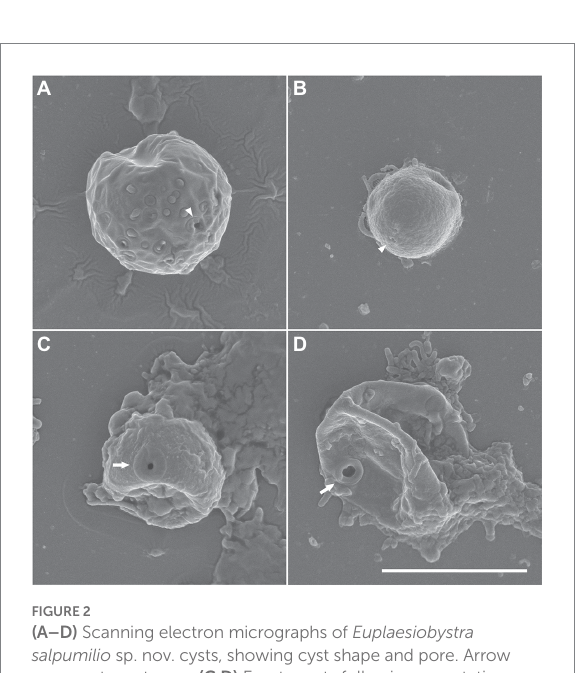
FIGURE 2 (A–D) Scanning electron micrographs of Euplaesiobystra salpumilio sp. nov. cysts, showing cyst shape and pore. Arrow represents cyst pore. (C,D) Empty cysts following excystation. Scale bar: 5 μ m for all